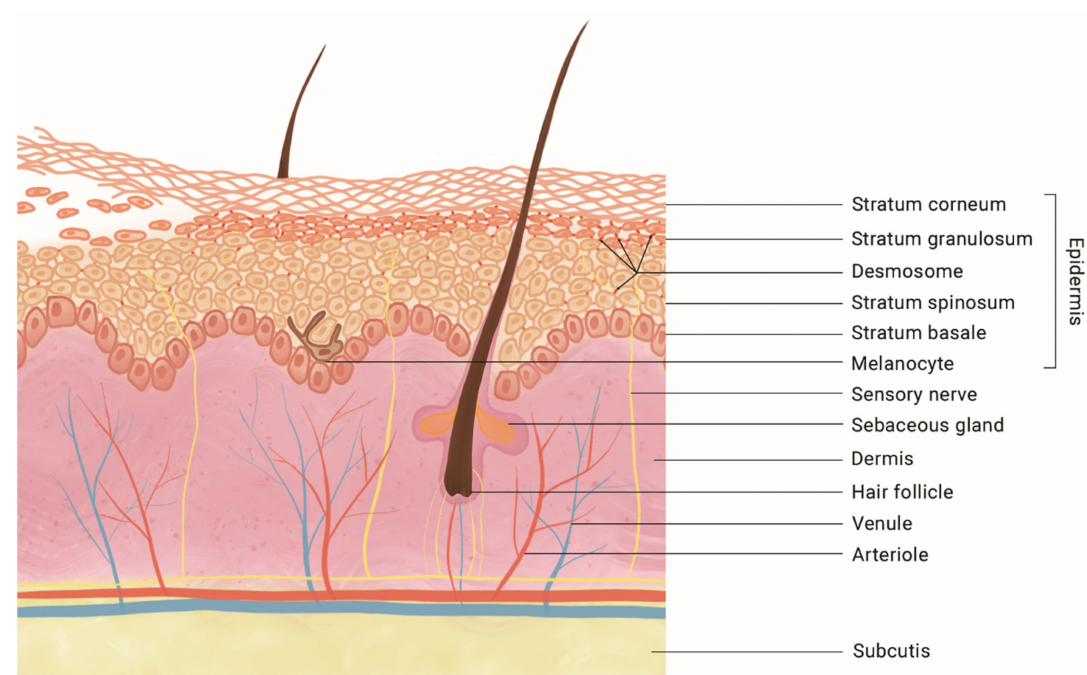
Figure 3. Schematic overview of intra-epidermal skin splitting in staphylococcal scalded skin syn- drome. The exfoliative toxins produced by Staphylococcus aureus cleave the desmosomal protein Desmoglein-1 (in red, see arrows), causing acantholysis at the level of the granular layer (as pictured on the left). The toxins do not affect Desmoglein-3, which retains its adhesive function in the deeper epidermal layers, as well as in mucous membranes (not pictured)